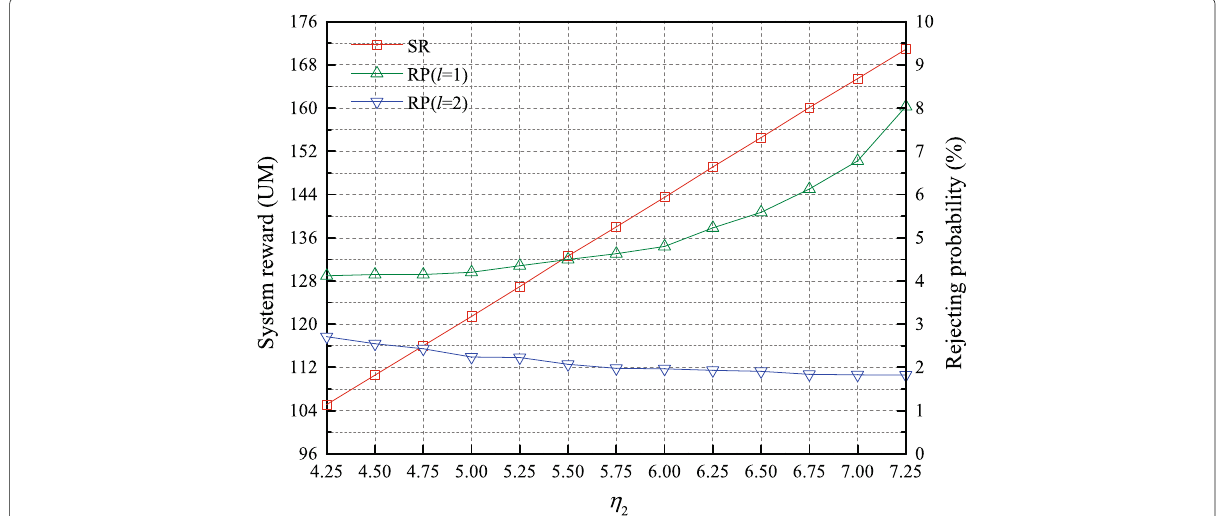
Fig. 13 SR and RPs under different η 2 . This figure shows the impacts of the income on the evaluation results, in which η 2 represents the ratio of R 2 and R 1